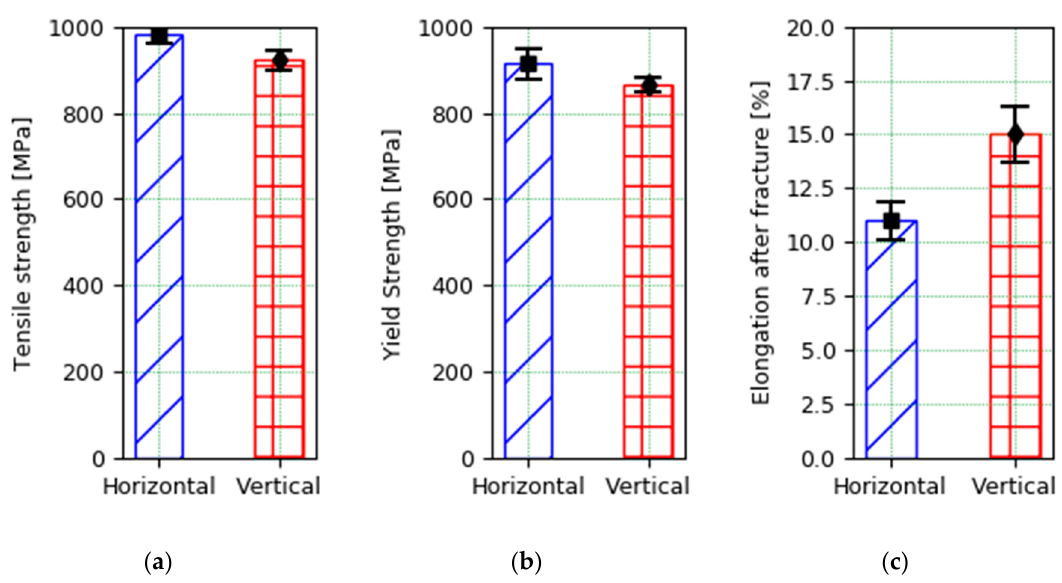
Figure 8. Mechanical properties of the Ti6Al4V PAW-WAAM wall. ( a ) Tensile strength; ( b ) Yield strength; ( c ) Elongation after fracture.